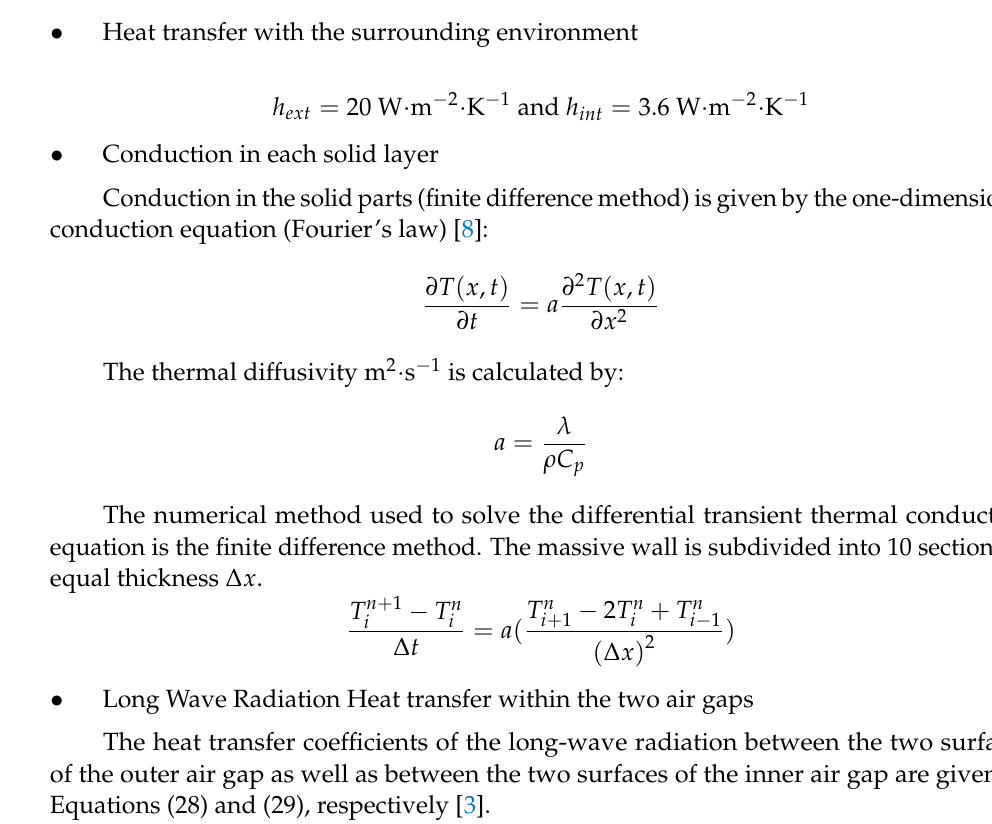
Figure 11. Schematic of the thermal resistance network for the VSW.